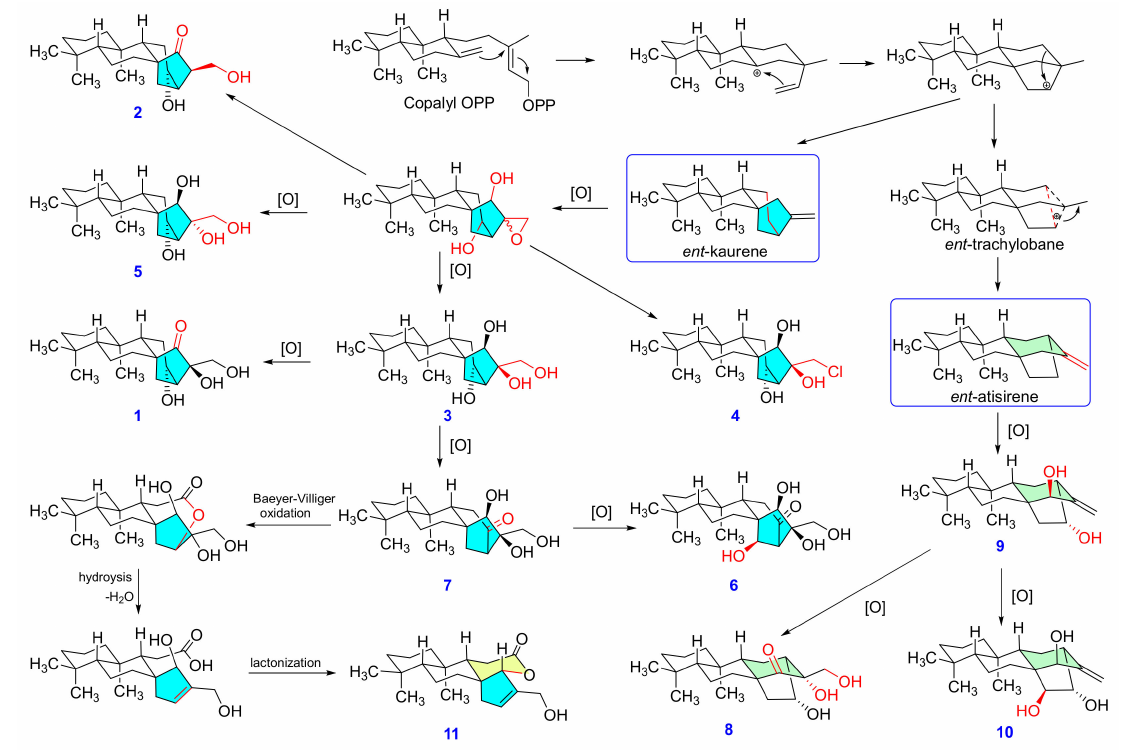
Figure 3. The biogenic pathway of the isolates from M. procumbens